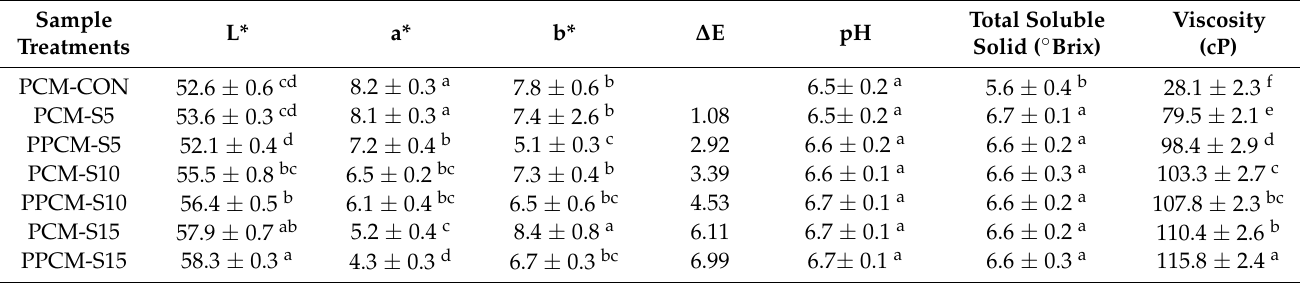
Table 2. Physicochemical properties of unpasteurized and pasteurized purple corn milk extracted from steamed purple corn